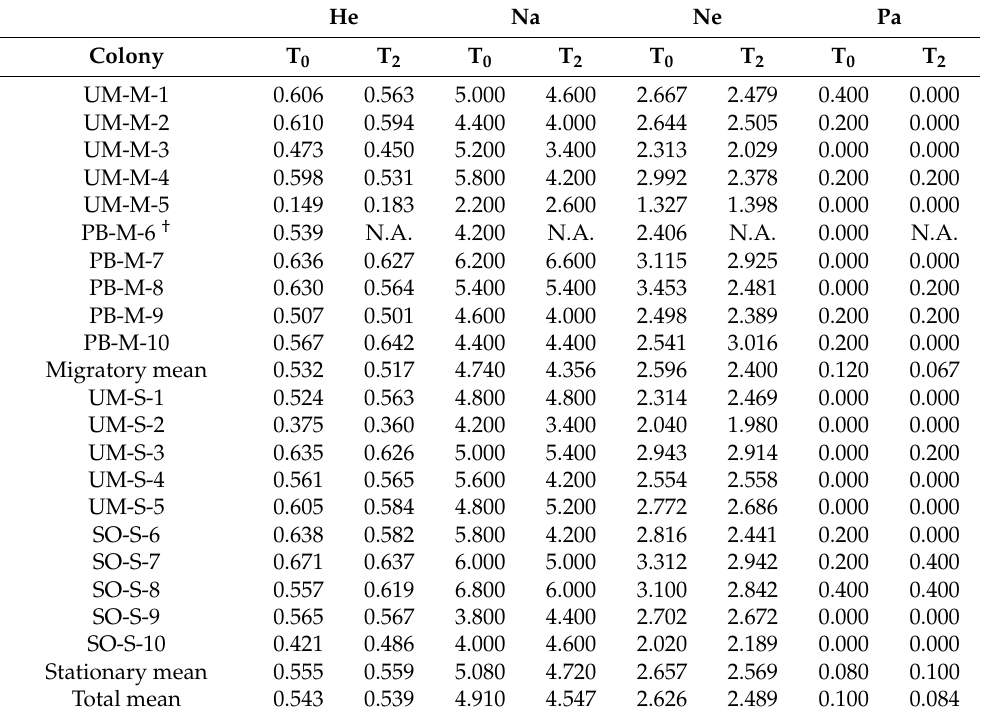
Table 1. Population genetic parameters of migratory (M) and stationary colonies (S) at two sampling times: at the beginning of the experiment (T 0 , except the stationary colonies from Soria (SO-S) that were sampled at T 1 ) and at the end of the migratory period (T 2 ). Colony PB-M-6 † already died off at T 2 , therefore, data is not available